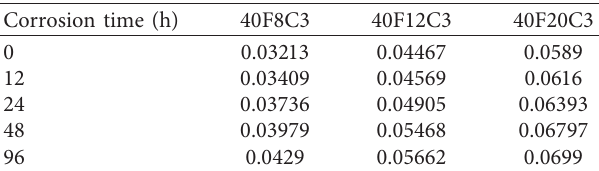
Figure 4: (a) The surface temperature depends on time for specimens with different depths of the concrete cover, and (b)–(d) the rate of the temperature rise dependence on the corrosion time for specimens with different diameters of the internal steel bar and with different concrete cover depths. Table 2: The rate of the temperature rise dependent on the cor- rosion time for different specimens with different rebar radiuses ( °